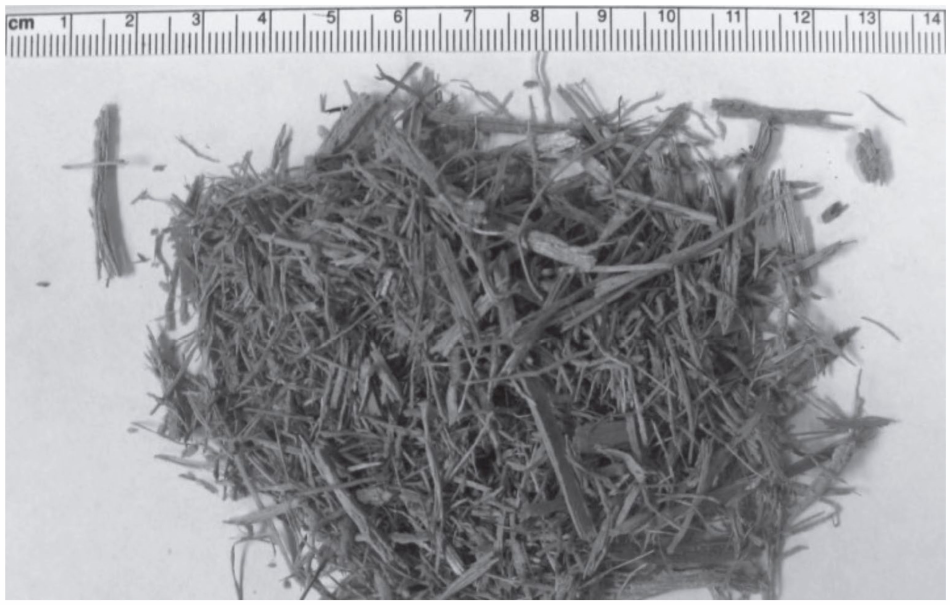
Figure 9. Sugarcane bagasse as received from the ethanol producing company. Adapted with permission from Ref.